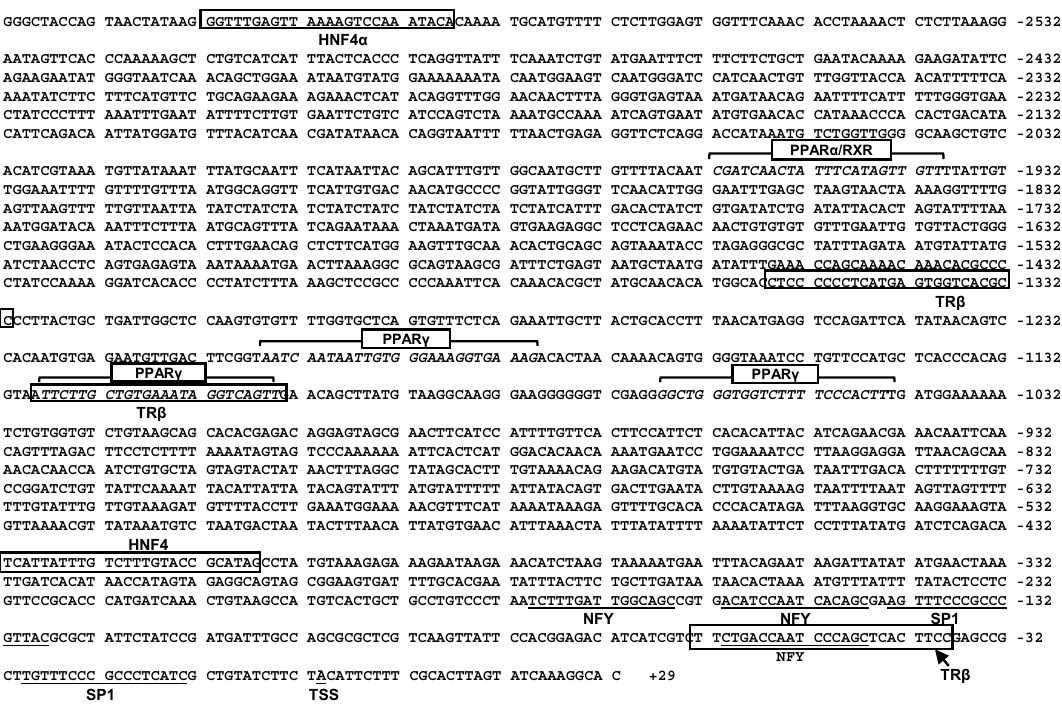
Figure 4. Nucleotide sequence of grass carp CPT I α 2a promoter. +1 denotes the TSS obtained from RLM-5 ′ RACE experiment. Numbers present distance from TSS. The highlighted sequences show putative transcription factor binding sites.